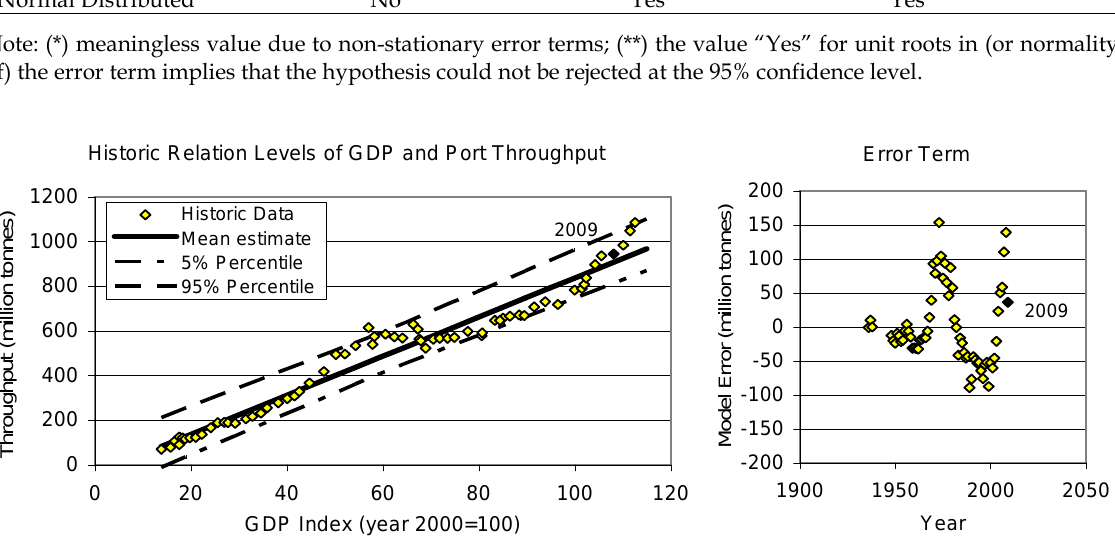
Figure 3. Simple Linear Regression between levels of GDP and Port